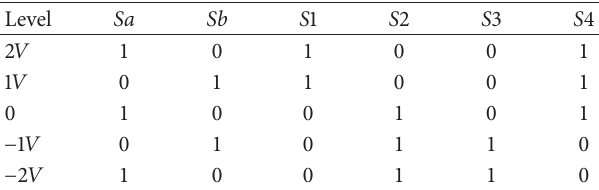
Figure 3: Switching operation for 1 𝑉 -level output.